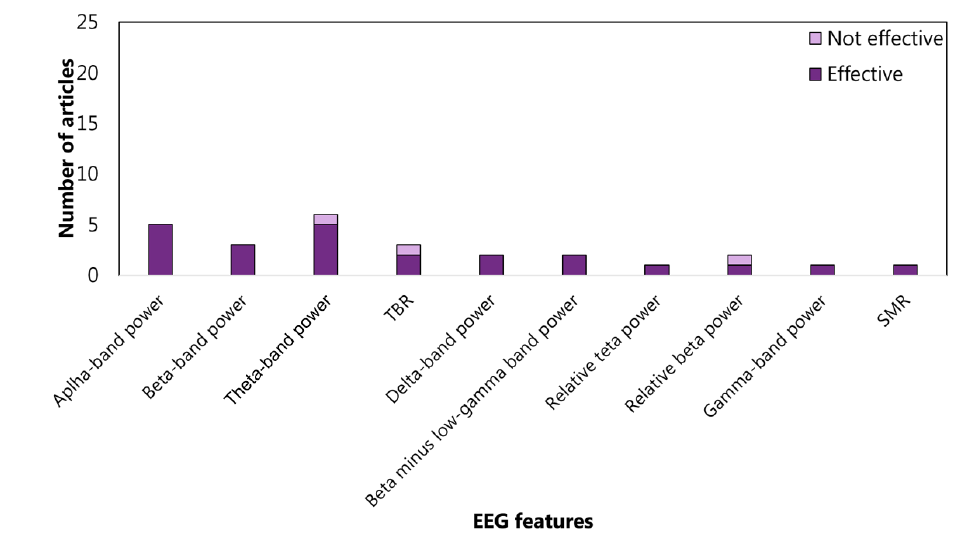
Figure 11. Articles focusing on the relationship between visuo-spatial working memory and EEG features from frequency domain. Theta-band power is the feature most studied: five articles verified (effective) the relationship, and one article did not (not effective). TBR: theta–beta ratio; SMR: senso- motor rhythm.